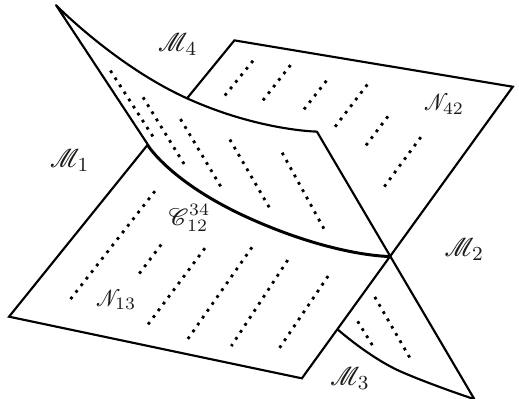
Figure 1. The spacetime manifold M splits into a union of four-dimensional cells M 1 , M 2 , . . . , which contain no local degrees of freedom